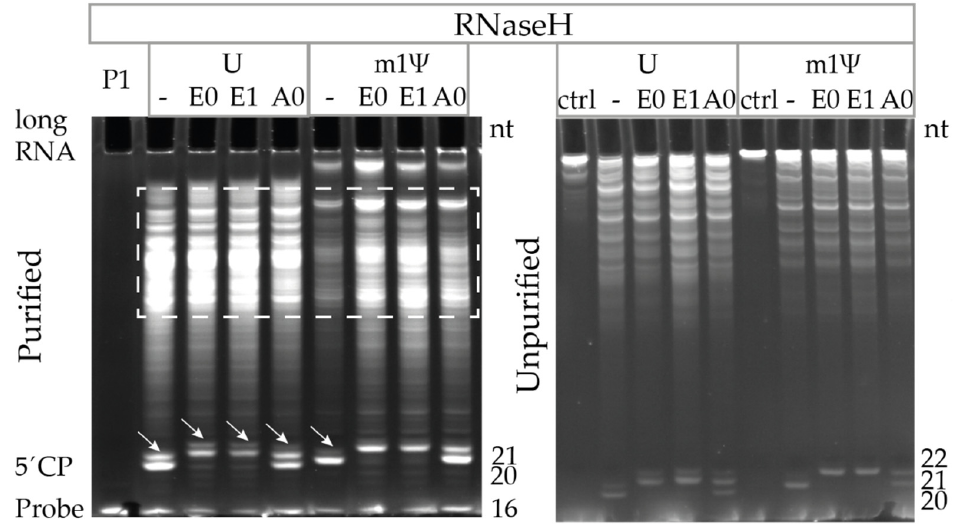
Figure 6. Ribozyme-mediated cleavage assay is superior to the RNase H cleavage assay. RNase H probe (P1) was hybridized, and RNase H cleaved a set of U-containing or m1 Ψ -containing RNAs: Uncapped (-), enzymatic cap0 (E0), enzymatic cap1 (E1), and ARCA (A0). Cleaved RNA fragment mixtures were applied to silica-based columns for purification and visualized using 21% PAGE, 8 M urea (purified) or visualized using 21% PAGE, 8 M urea without silica-based column purification (unpurified). White arrows: Additional +1 nt band, dashed square: RNA degradation caused by RNase H. RNase H probe P1 or uncleaved RNA (ctrl) were used as controls. 5 ′ CP: 5 ′ cleavage prod- ucts; nt: Nucleotides.